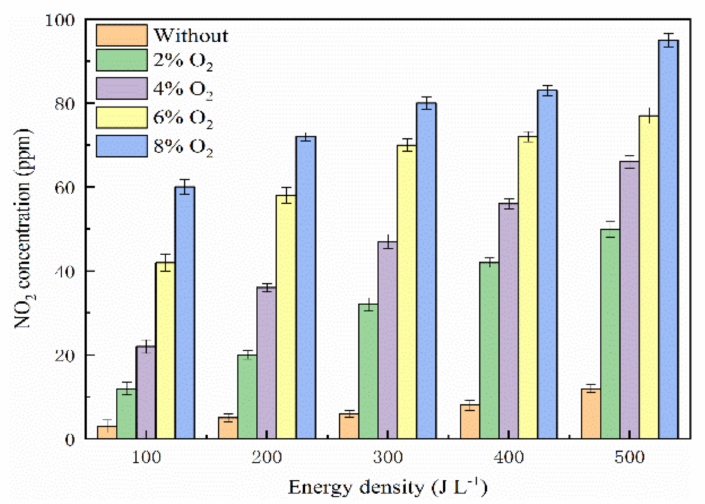
Figure 9. E ff ect of O 2 concentration on NO 2